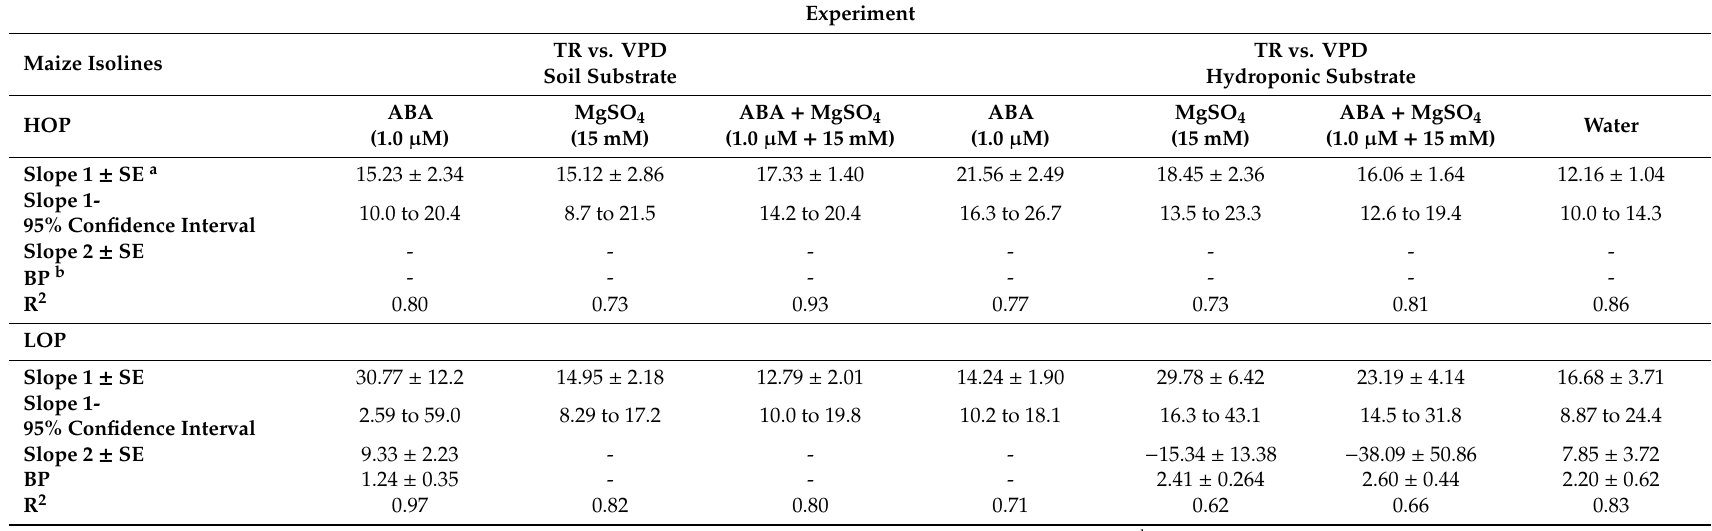
Table 1. Whole plant transpiration response to ABA (1.0 µ M), MgSO 4 (15 mM), and a combination (1.0 µ M + 15 mM) application under varying levels of VPD in two days (long-term chemical treatments). Results from two-segment linear regression include Slope 1 ( ± SE), 95% Confidence Interval of Slope 1, Slope 2 ( ± SE), BP, and their R 2 . The results of those fitted by a single linear regression include the slope and R 2